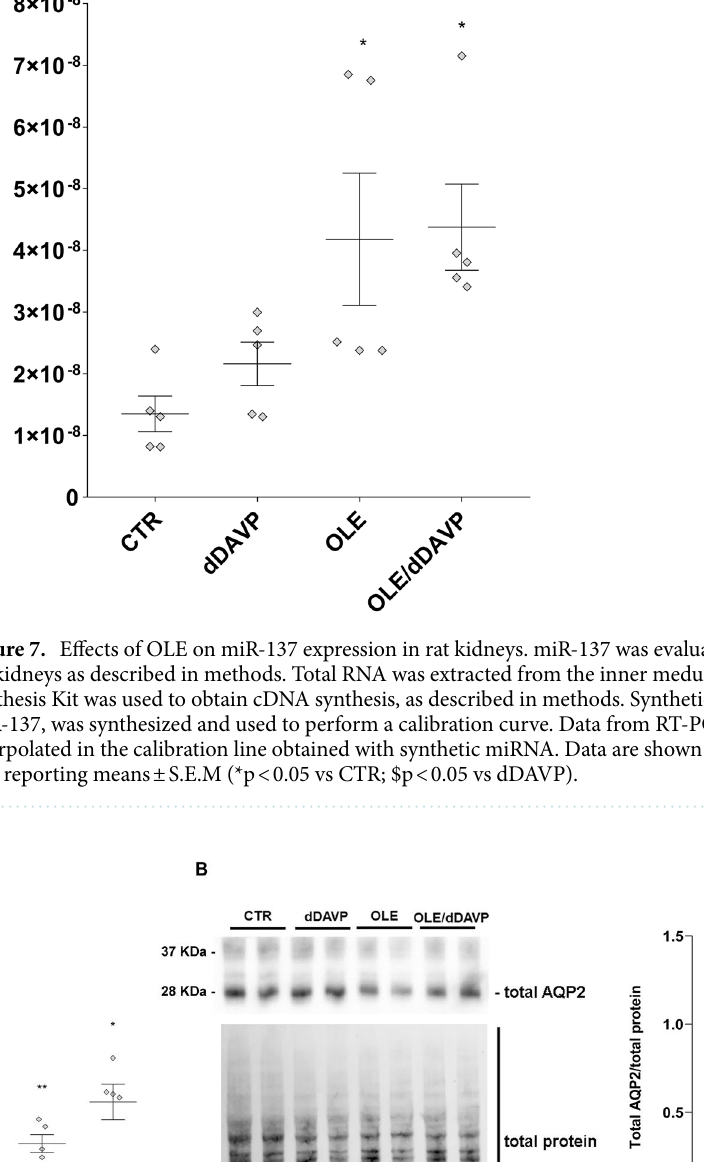
the mitochondrial oxidative stress that caused cell apoptosis 36 . Moreover, our previous study showed that the